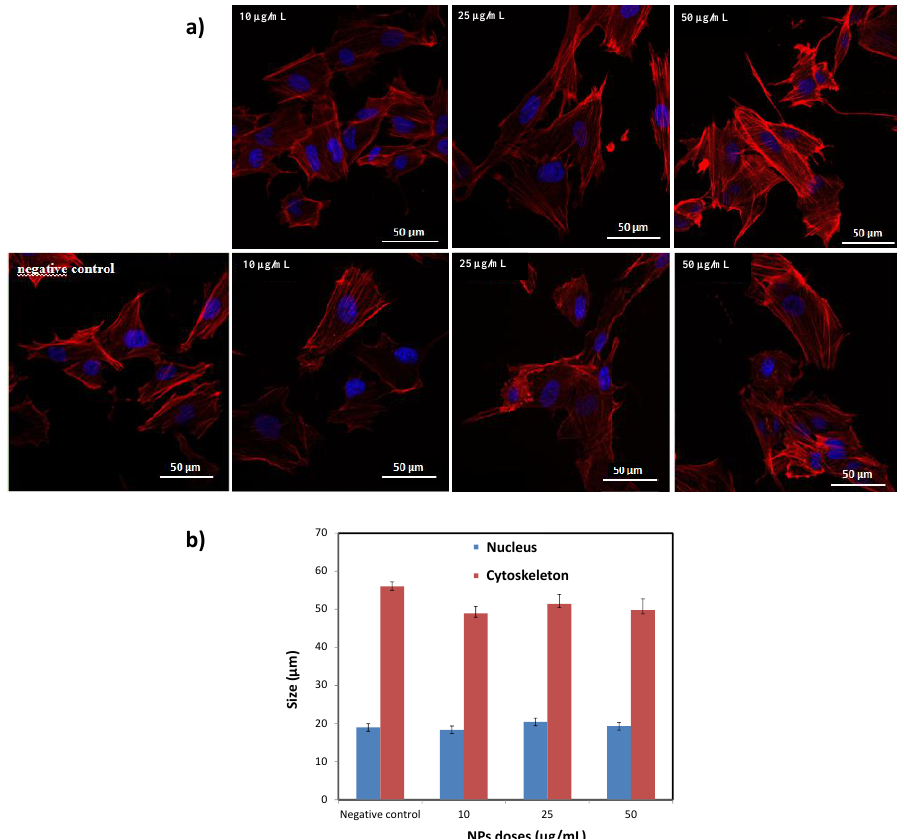
Figure 10. ( a ) Confocal fluorescence microscopy images collected on BJH cells incubated during 48 h with different doses of citrated β-NaY 0.8 Eu 0.2 F 4 @γ-Fe 2 O 3 particles. Note the nucleus and the cytoskeleton were counterstained with the blue and red emitting DAPI and TRITC dyes, respectively. ( b ) Nucleus and cytoskeleton size distributions (based on the size analysis of a total of 25 cells) were added to appreciate eventual morphological changes after contact with NPs. In the present case there is nothing significant.